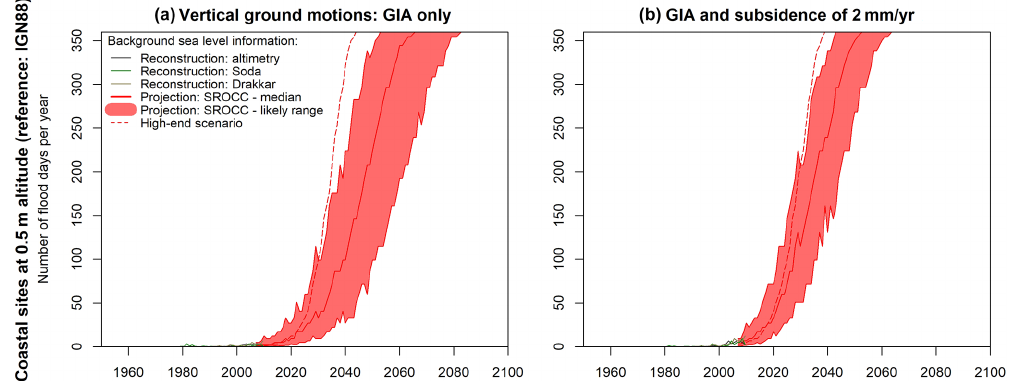
Figure 8. Reconstruction and projections of chronic flooding events, for two subsidence scenarios and a coastal site located at an altitude of 0.5m (local reference frame, IGN88). The color code is the same as in Fig.